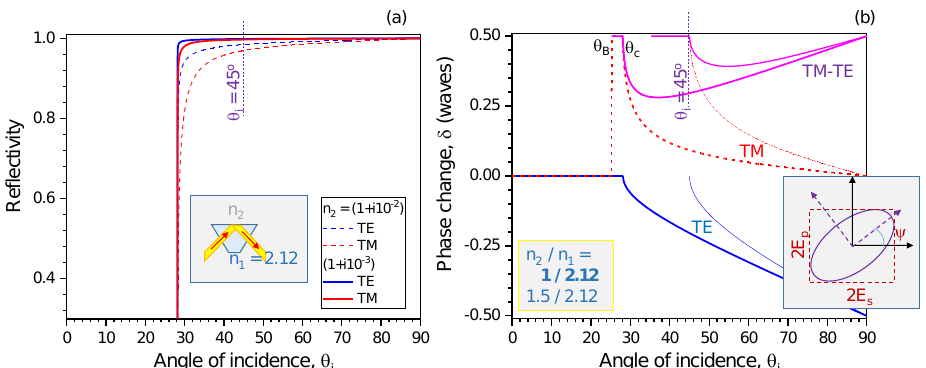
Figure A1. Visualisation of Equations (A1)–(A4). Reflection coefficients R TE , TM vs. angle of incidence θ i for the ATR prism, e.g., n 1 = 2.12 at THz spectral range. Absorption in air is added by the imaginary part of refractive index k 2 = 10 − 2 and 10 − 3 . The inset shows ATR geometry and conventions. ( b ) The phase change upon reflection for the TE and TM modes governed by the real part of refractive indices n = n 2 / n 1 . The polarising Brewster angle is given by θ B = tan − 1 ( n ) and the critical angle θ c = sin − 1 ( n ) . Thinner lines correspond to the case when the sample has a refractive index of n 2 = 1.5. The right inset in ( b ) shows the polarisation ellipse after the